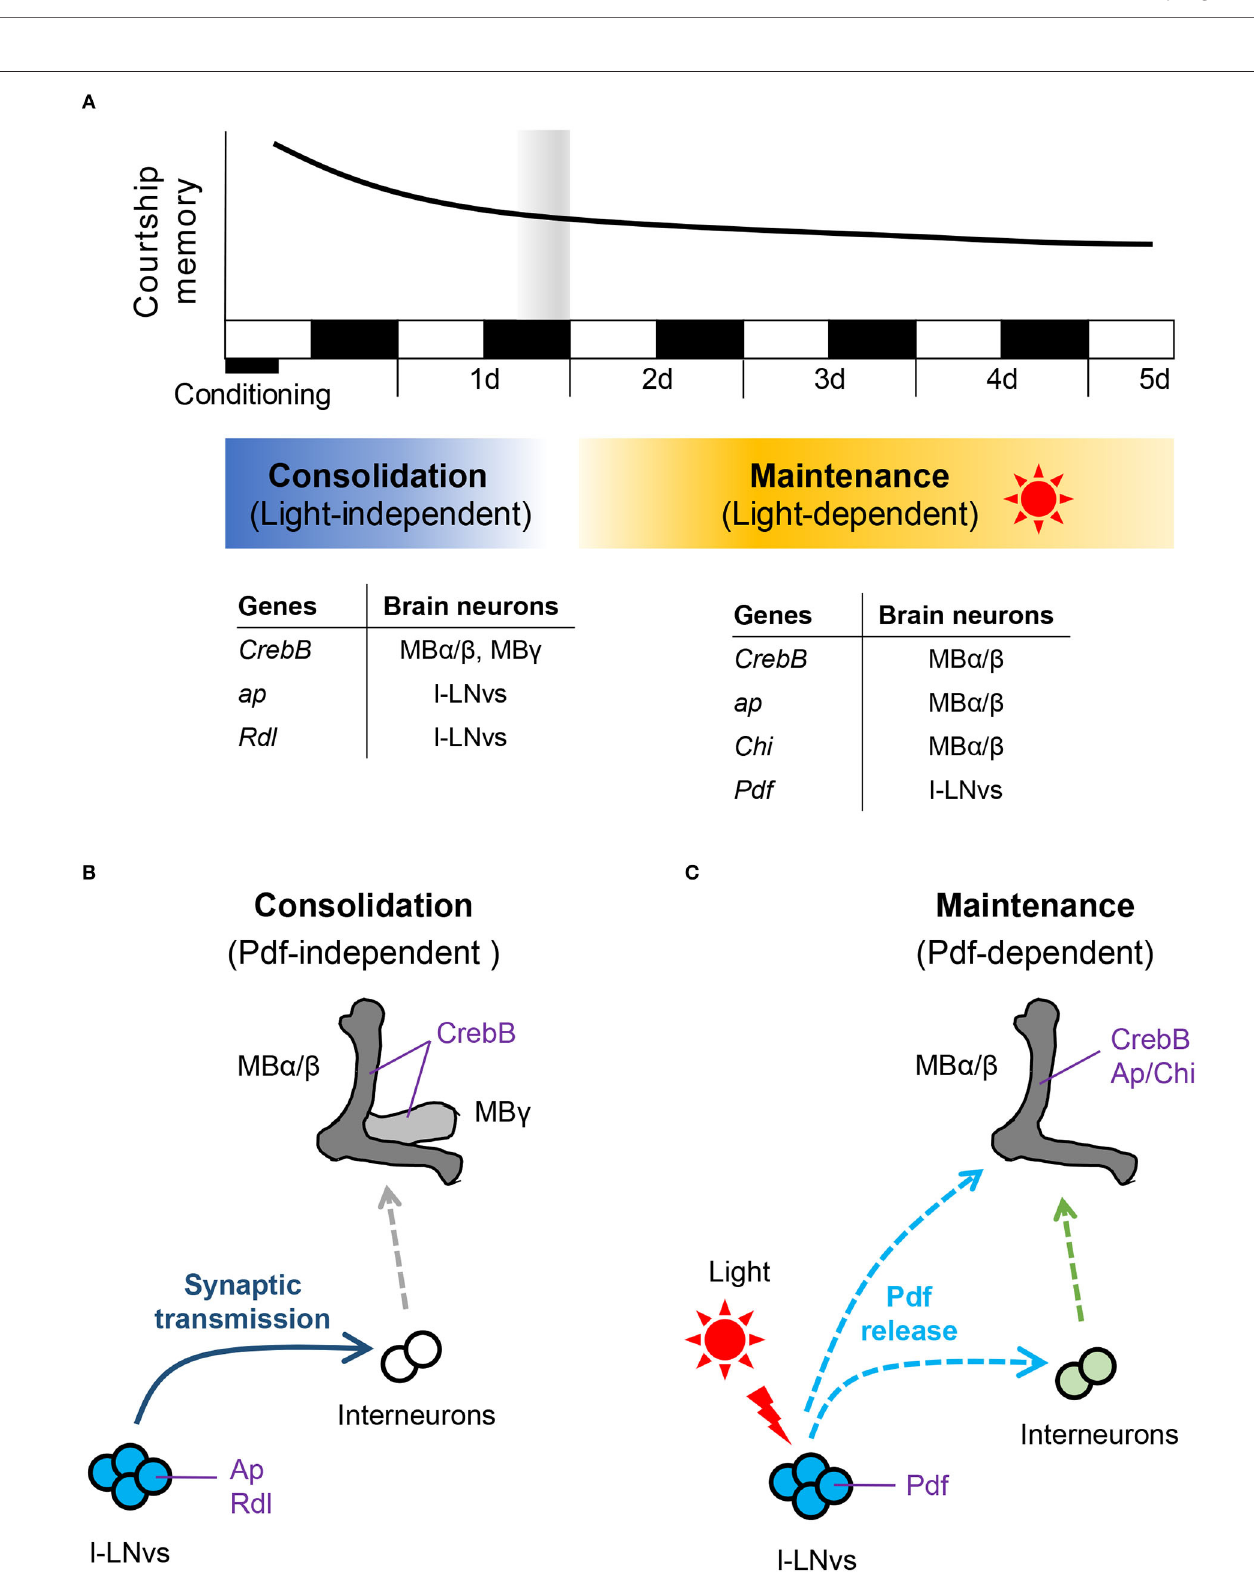
FIGURE 1 | Molecular and cellular basis of courtship memory in Drosophila . (A) Schematic diagram of courtship memory processing and genes regulating consolidation and maintenance of courtship LTM. ap , apterous ; Rdl , Resistant to dieldrin ; Chi , Chip ; Pdf , Pigment-dispersing factor . (B) Pdf-independent LTM consolidation. Synaptic transmission from Pdf-positive l-LNvs modulates the consolidation of courtship LTM. (C) Pdf-dependent LTM maintenance. Pdf release driven by light is essential for the maintenance of courtship LTM.